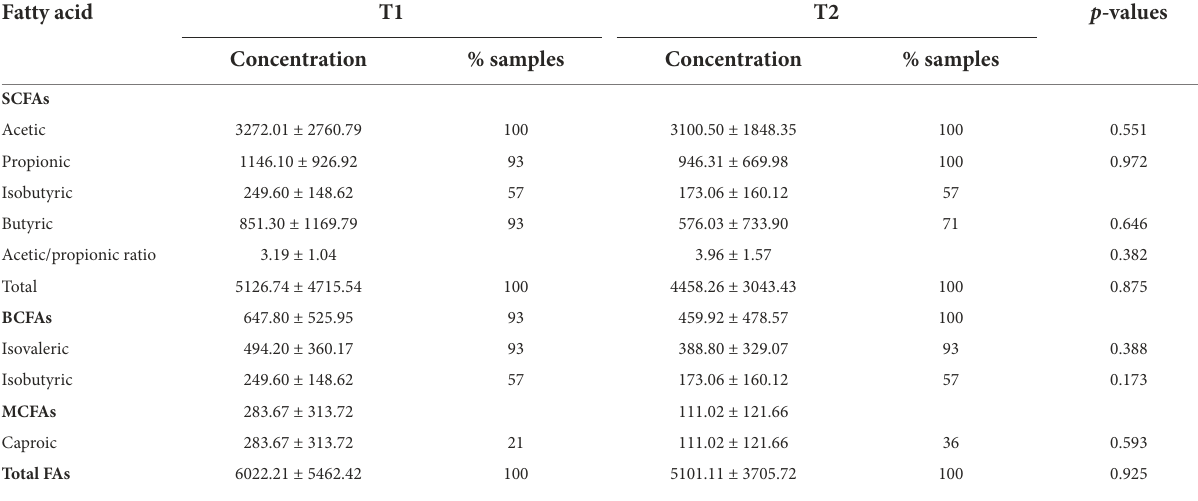
TABLE 5 Concentration ( μ g/g) and frequency of detection (% samples) of fecal fatty acids (FAs) at day 0 (T1) and 120 (T2). The p -values are related to the concentration de the FAs at both sampling